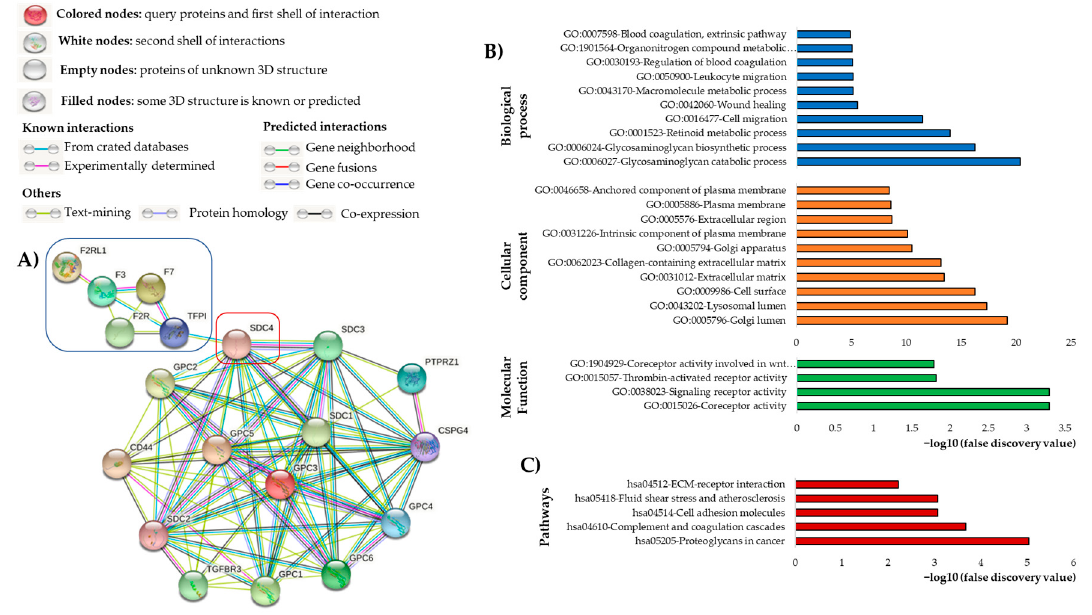
Figure 4. Network of proteoglycans with tissue factor pathway interactors. ( A ) STRING database output depicting functional and physical interactors of TF pathway-related proteins (in the blue box) and HSPGs obtained from http://string-db.org/ (accessed on 16 May 2022) [352]. Interactions with a combined score > 0.700 were defined as statistically significant. ( B ) GO (gene ontology) analysis of the interconnection between HSPGs and TF pathway-related pathways. The 10 most significantly ( p < 0.05) enriched GO terms in molecular function (green), cellular component (orange), and biological process (blue) branches are presented. ( C ) KEGG pathway analysis (red). All the adjusted statistically significant values of the terms were negative 10-base log-transformed. The color coding of lines and nodes is shown in the figure.